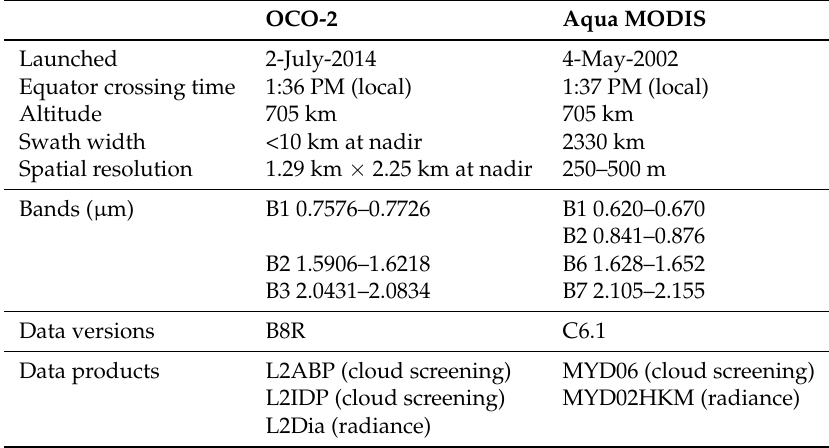
Table 2. Sensor characteristics and data used in this